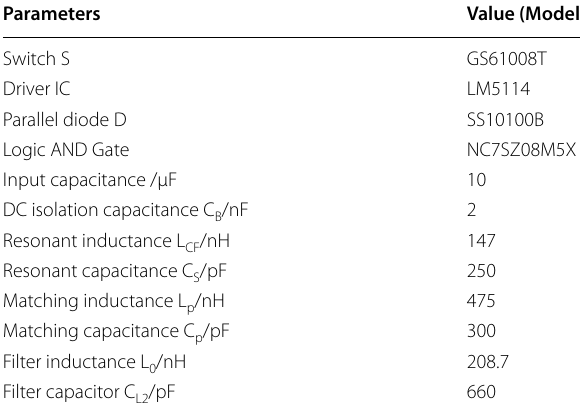
Table 1 Key parameters and component types of the prototype